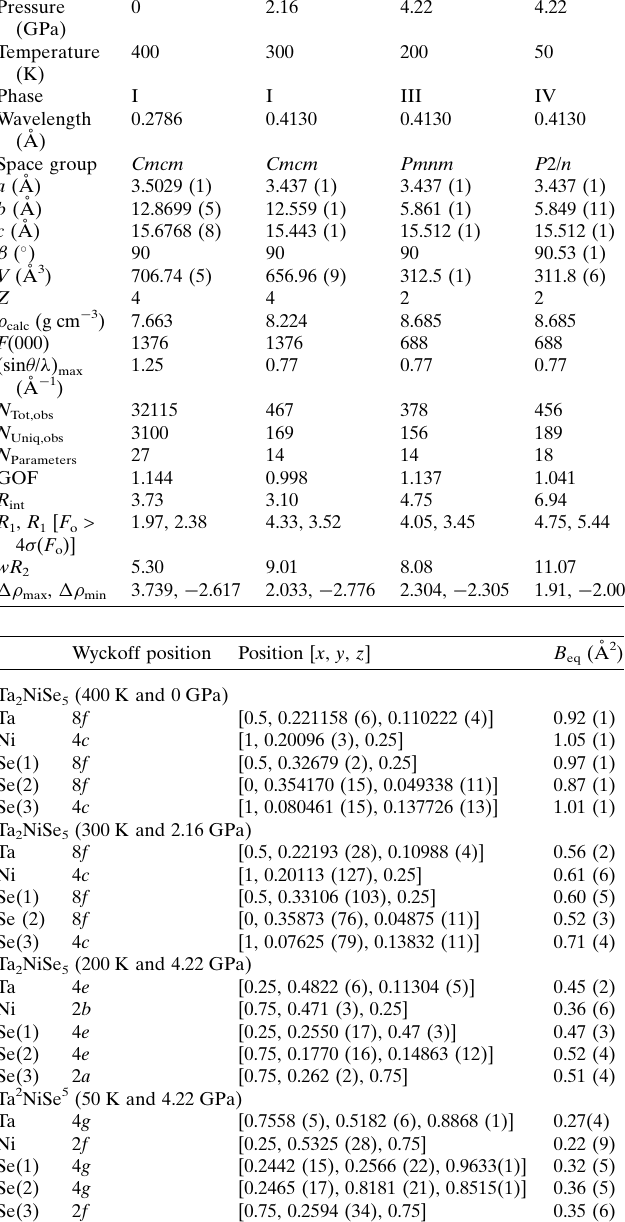
Table 1 Crystallographic data for Ta 2 NiSe 5 at P = 0, 2.16 and 4.22 GPa including atomic coordinates.